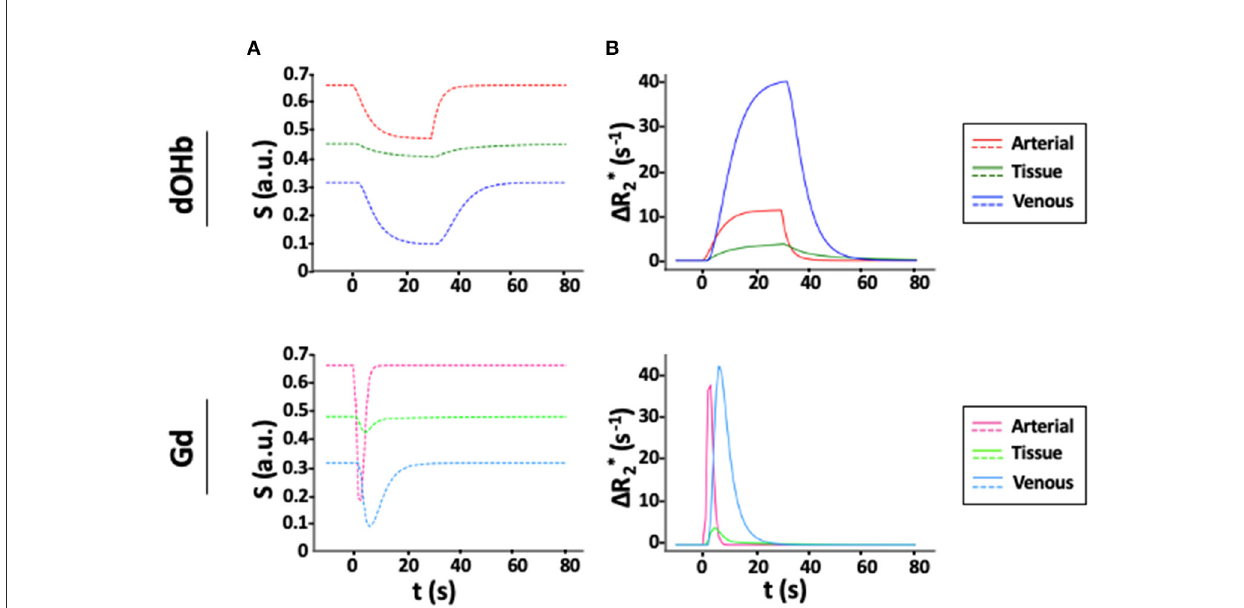
FIGURE2 Simulated S(t) and R * 2 ( t ) for Gd and dOHb Contrast. (A) S(t) in artery ( CBV = 100%), tissue ( CBV = 4%, MTT = 3s), and vein ( CBV = 100%, MTT = 4s) following contrast agent administration of dOHb (top) and Gd (bottom). (B) Corresponding R * 2 ( t ). Note that the simulated dOHb profile follows a 98–75% S a O 2 and Gd profile has a peak input concentration of 2mM.